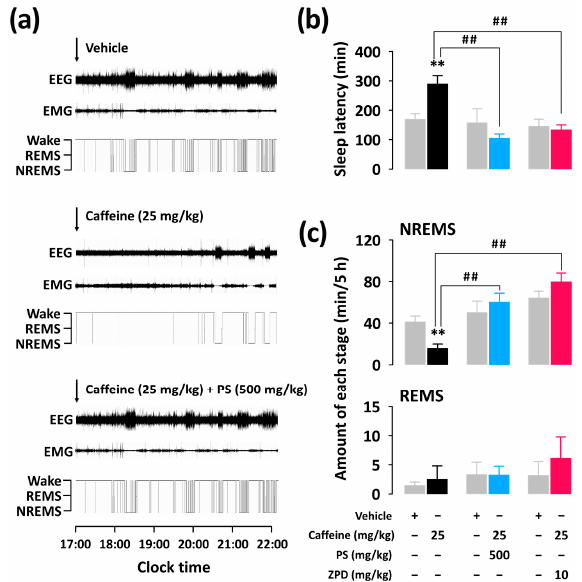
Figure 2. Sleep-wake profiles in C57BL/6N mice after oral administration of caffeine alone and co-administration of PS or ZPD with caffeine. ( a ) Typical EEG and EMG recordings and the corresponding hypnograms in a mouse treated with vehicle, caffeine, or caffeine + PS. ( b ) Effects of caffeine, caffeine + PS, and caffeine + ZPD on sleep latency. ( c ) Amount of NREMS and REMS during the 5-h period after administration of vehicle, caffeine, caffeine + PS, and caffeine + ZPD. Grey bars indicate the baseline day (vehicle). Each value represents the mean ± standard error of the mean of 7– 8 mice per group. ** p < 0.01, significantly different from the vehicle control and ## p < 0.01, significant difference between two groups (unpaired Student’s t -test). EEG, electroencephalogram; EMG, electromyogram; NREMS, non-rapid eye movement sleep; PS, a standardized phlorotannin supplement; REMS, rapid eye movement sleep; Wake, wakefulness; ZPD, zolpidem.